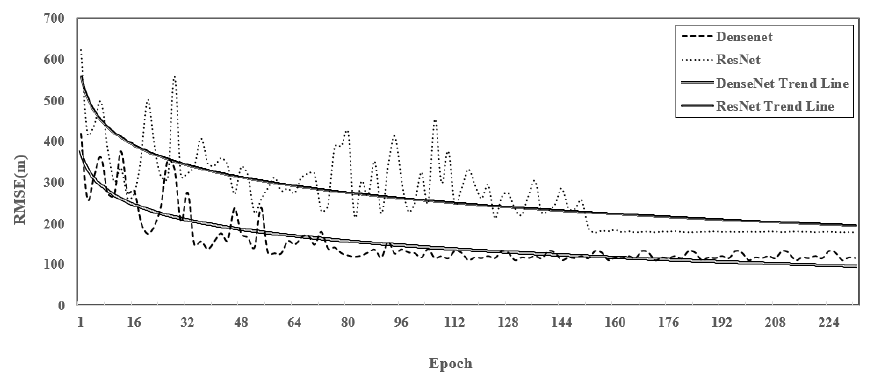
Figure 7. RMSEs of the DenseNet and ResNet models with the SGD and ADAM optimizers.